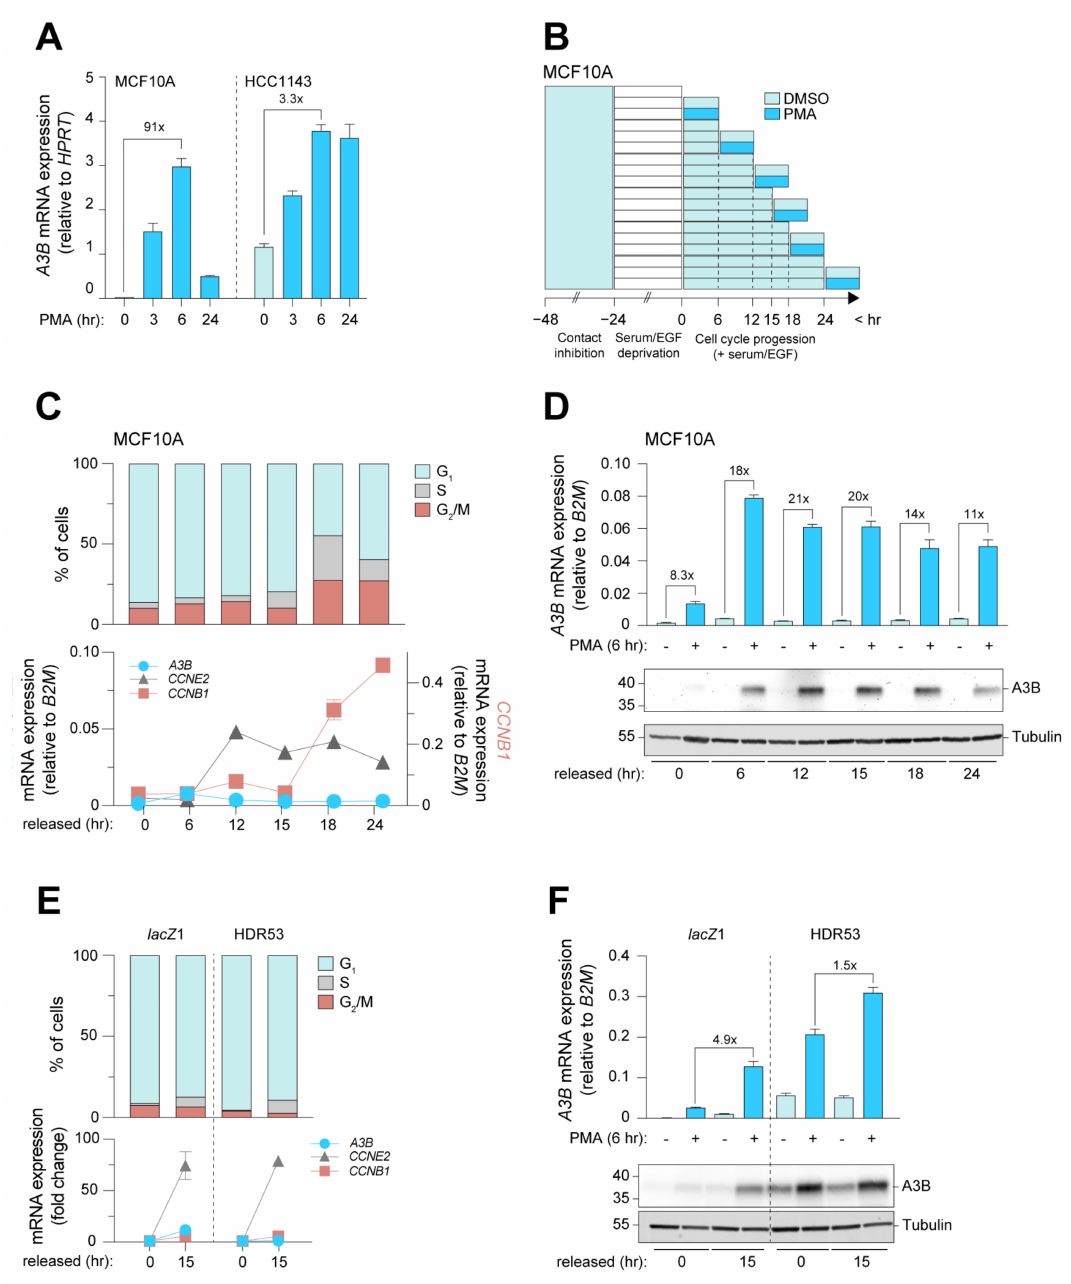
Figure 4. Induction of A3B expression is strongest in actively proliferating cells, and repression during G 0 is RB/E2F-dependent. ( A ) Analysis used to determine the most suitable model for the investigation of PKC/ncNF- κ B-induced expression of A3B within the context of cell cycle progression. Unsynchronized MCF10A and HCC1143 cells were exposed to PMA for up to 24 h, during which samples were taken for RT-qPCR analysis. Error bar represents SD. Data represent n = 2 independent experiments. ( B ) Method used to induce A3B expression using PMA at defined cell cycle stages of MCF10A cells. Teal denotes contact inhibition, followed by growth factor withdrawal (white), cell cycle progression (light blue), and treatment with PMA or vehicle. Samples taken at the start of each PMA or vehicle treatment served as independent controls for cell cycle progression. ( C ) Cell cycle progression of MCF10A as analyzed by PI staining followed by flow cytometry, and RT-qPCR analysis of A3B , CCNE2, and CCNB1 . Error bar represents SD. Data represent n = 2 independent experiments. ( D ) A3B mRNA (top) and protein (bottom) expression upon PMA treatment during indicated time points following synchronization. Error bar represents SD. Data represent n =